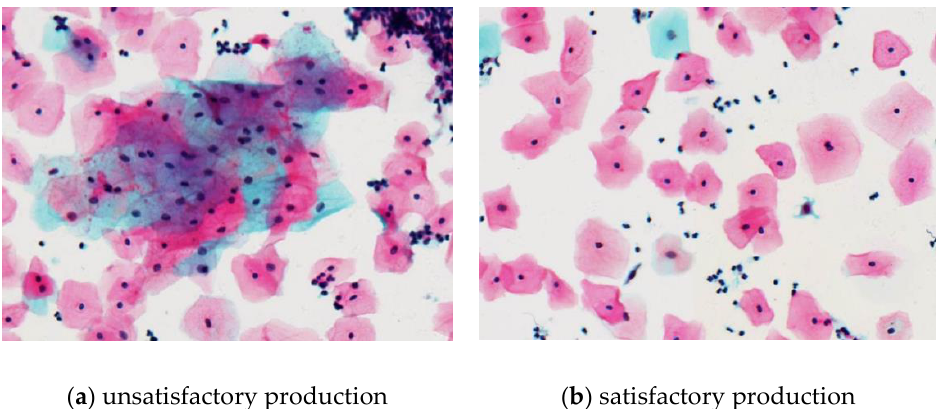
Figure 12. Comparison of film production with the microscope observation based on our proposed maker.